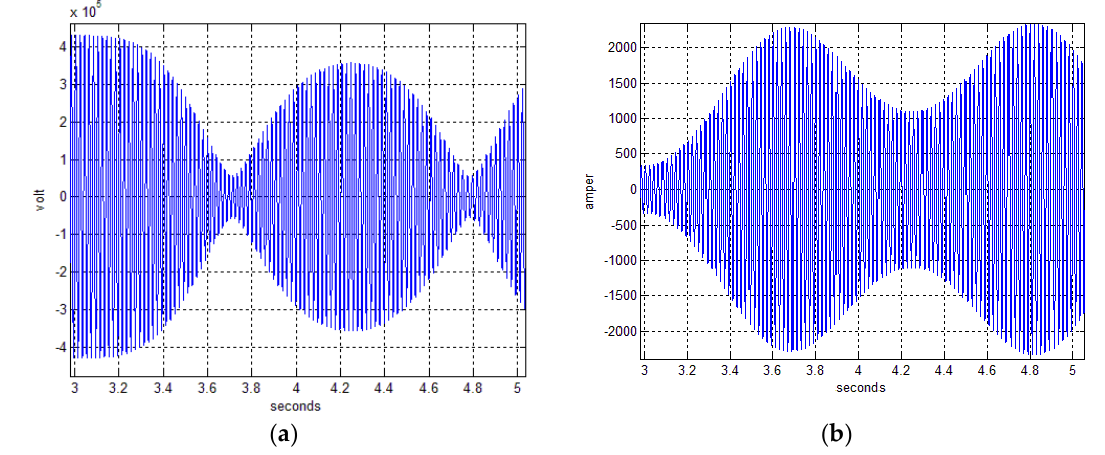
Figure 4. Details for starting point of active power oscillations on 400 kV transmission line during out- of-step condition during simulation scenario: ( a ) Voltage oscillations; and, ( b ) Current oscillations.